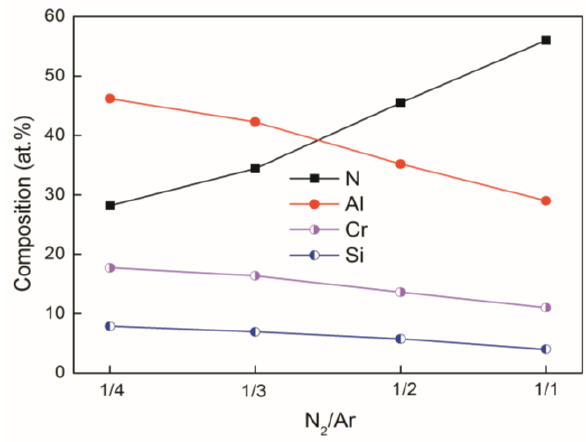
Figure 1. Chemical composition of the AlCrSiN coatings as a function of N 2 /Ar flow ratio.